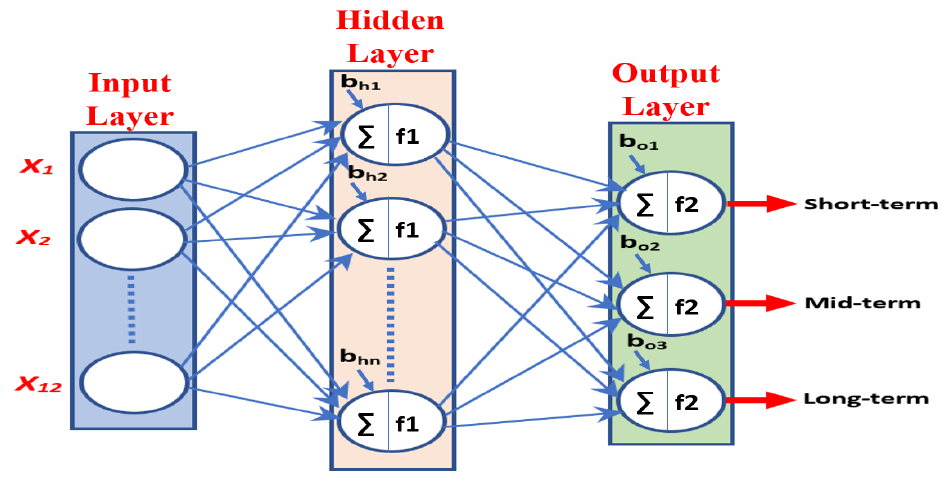
Figure 6. Simple neural network. f1 is tanh, and f2 is softmax. Table 6. Performance of the best OST prediction systems, with volumetric and location features and age factor, using NN. No. of Features